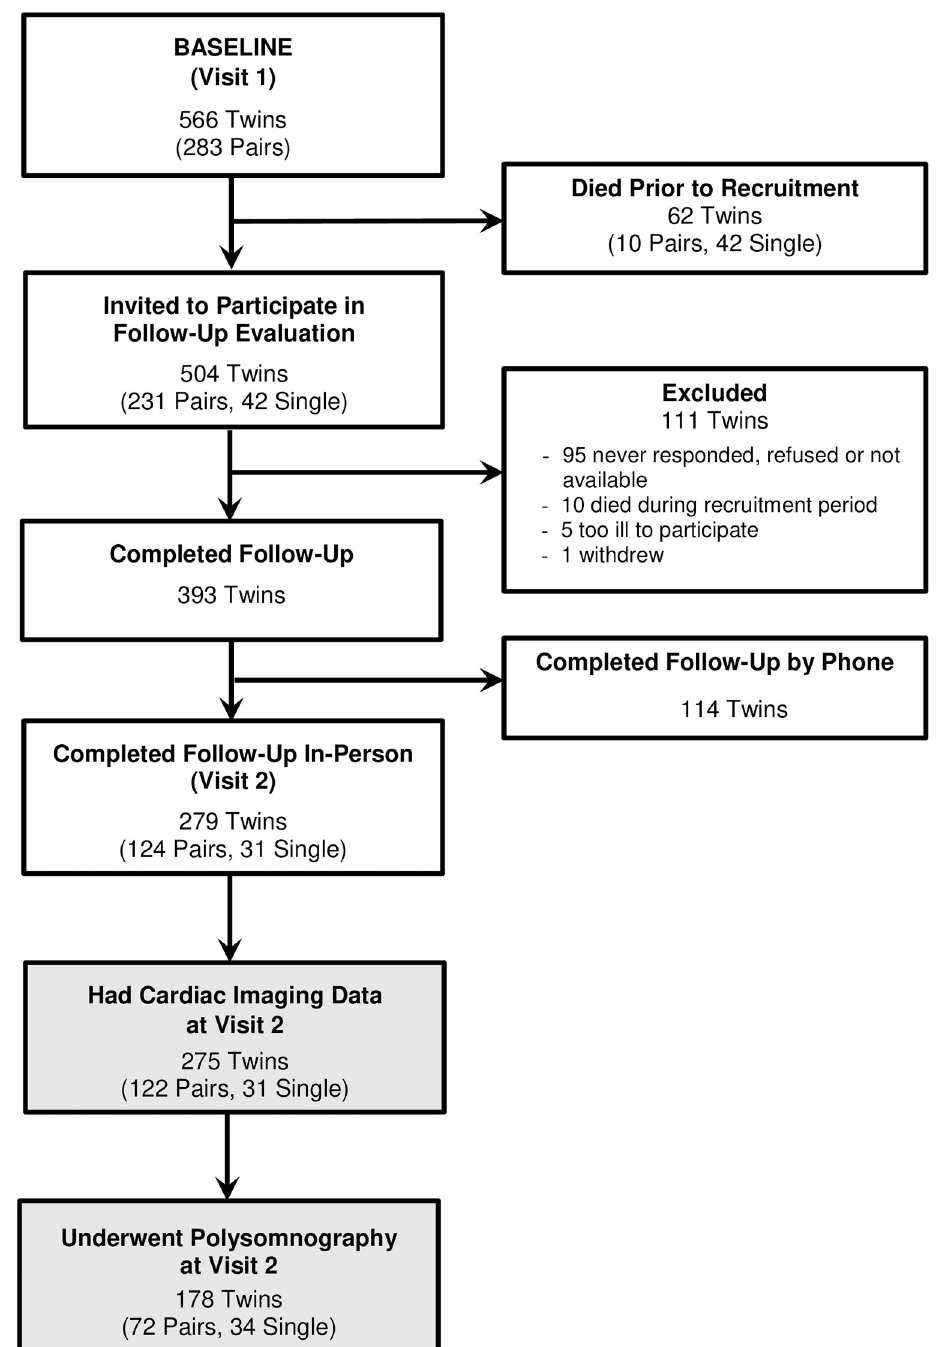
Fig 1. Participant flow diagram and construction of the analytical